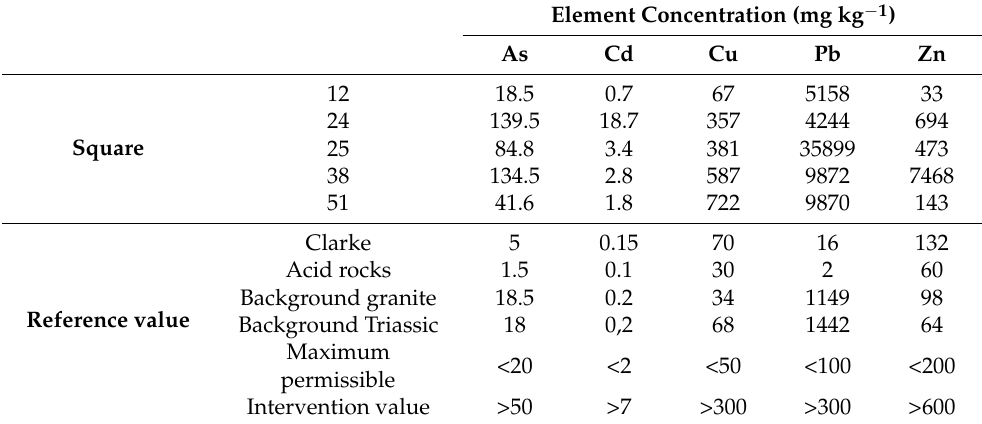
Table 2. Abundances of elements of environmental concern, Clarke value, mean concentration value for acidic rocks, background values and legal values: maximum permissible and compulsory treatment values according to the legislation of the Autonomous Community of Andalusia for agricultural soils of the five squares studied. Note that in squares 12 and 24, background corresponds to granite substrate whereas for 25, 38, and 51, background levels correspond to the Triassic